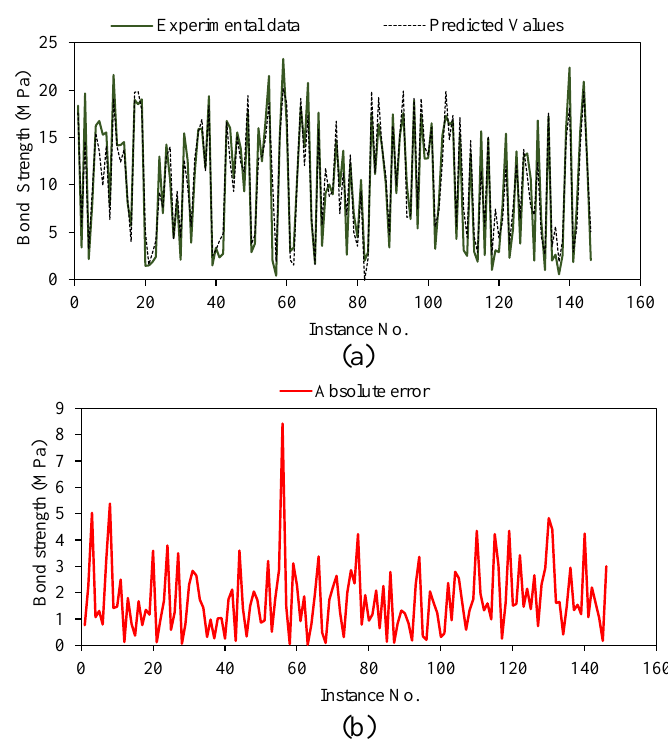
Figure 6. Error analysis of the optimised trial. ( a ) Tracing of experimental results by the predictions; ( b ) absolute errors for trial No. 10 predictions.